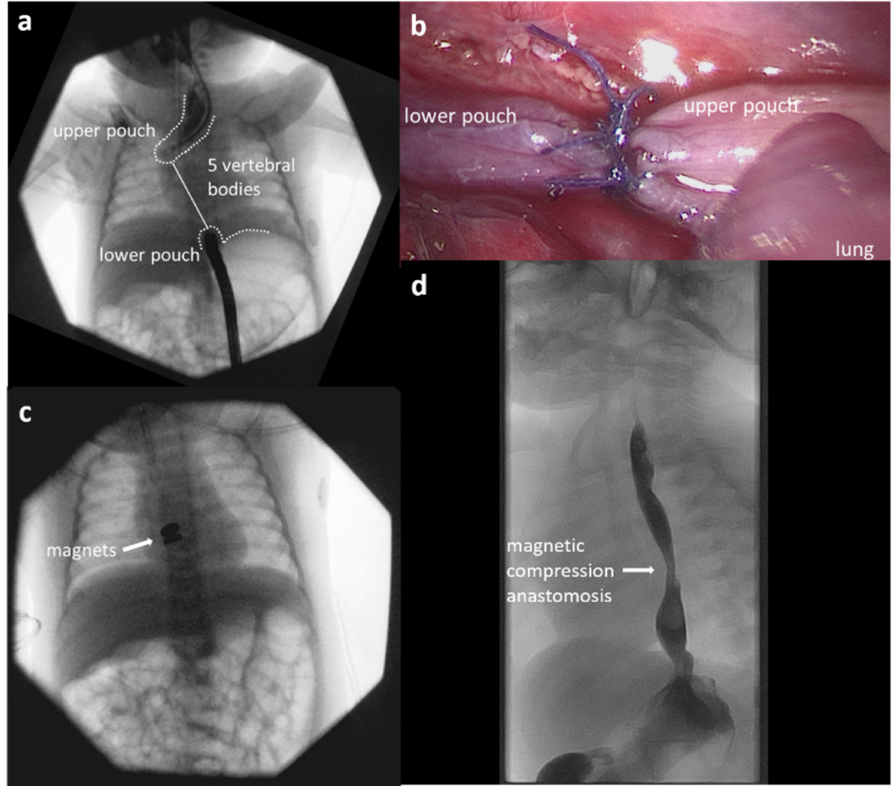
Figure 3. Case report. ( a ) Gap measurement by contrast study at 6 weeks of age. ( b ) Intraoperative view after approximation of the pouches with slip-knot sutures. ( c ) Mated magnets after endoscopic placement. ( d ) Contrast esophagography demonstrating a patent and watertight